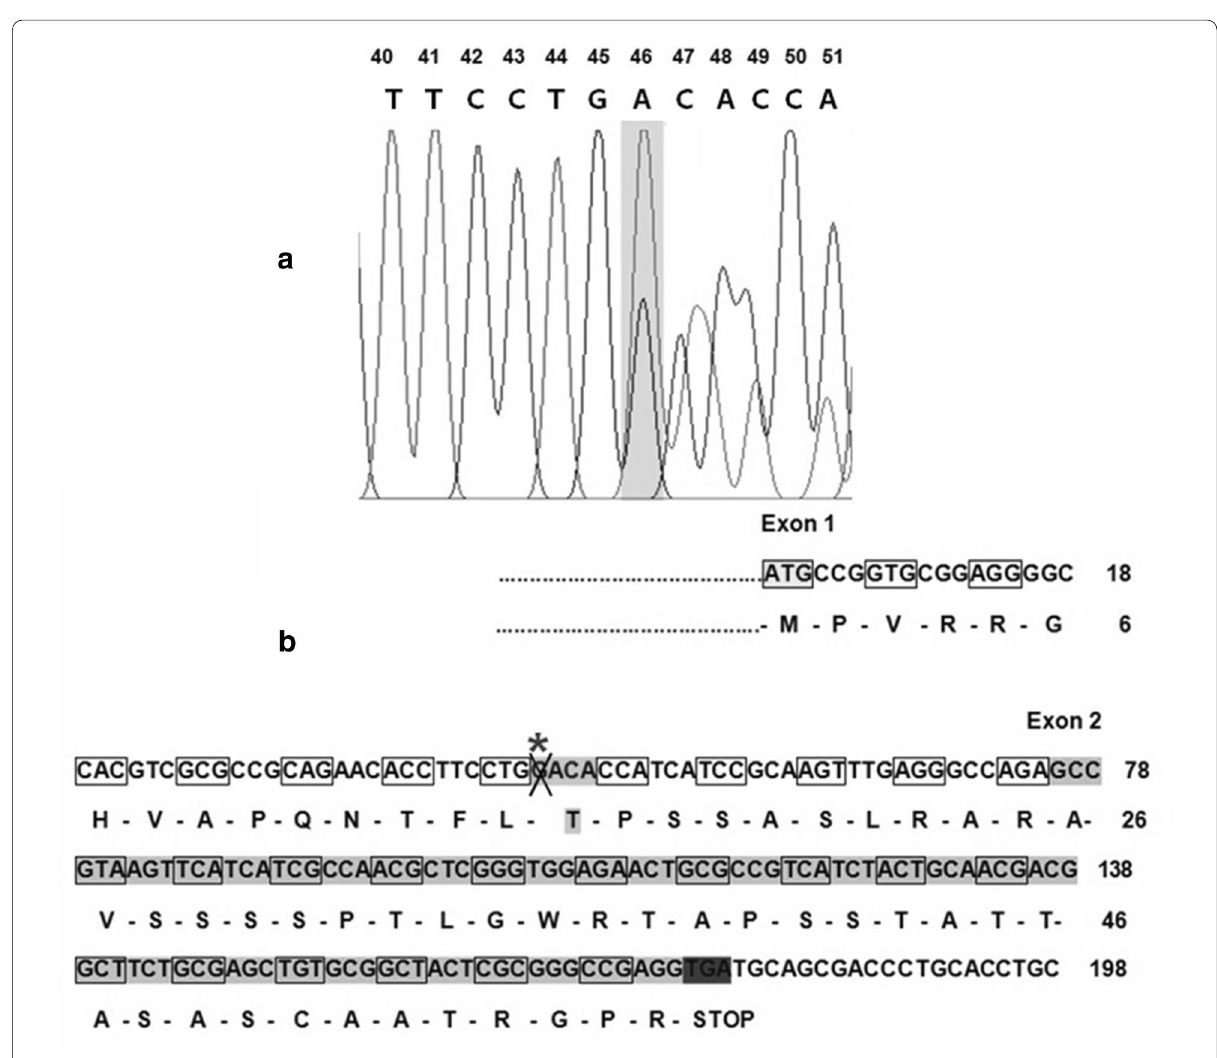
Fig. 2 a Electropherogram of the sequence surrounding the heterozygous mutation in KCNH2 from the proband’s genomic DNA. b Scheme of cDNA region involved in c.46delG variant. Nucleotides are separated into triplets (codon) with their corresponding amino acid. The deletion of guanine located at position 46 (asterisk) in exon 1 (codons marked in white) of KCNH2 gene produces a reading frame shift in the mutant allele that generates a premature stop codon in exon 2 (codons marked in gray) resulting in a truncated